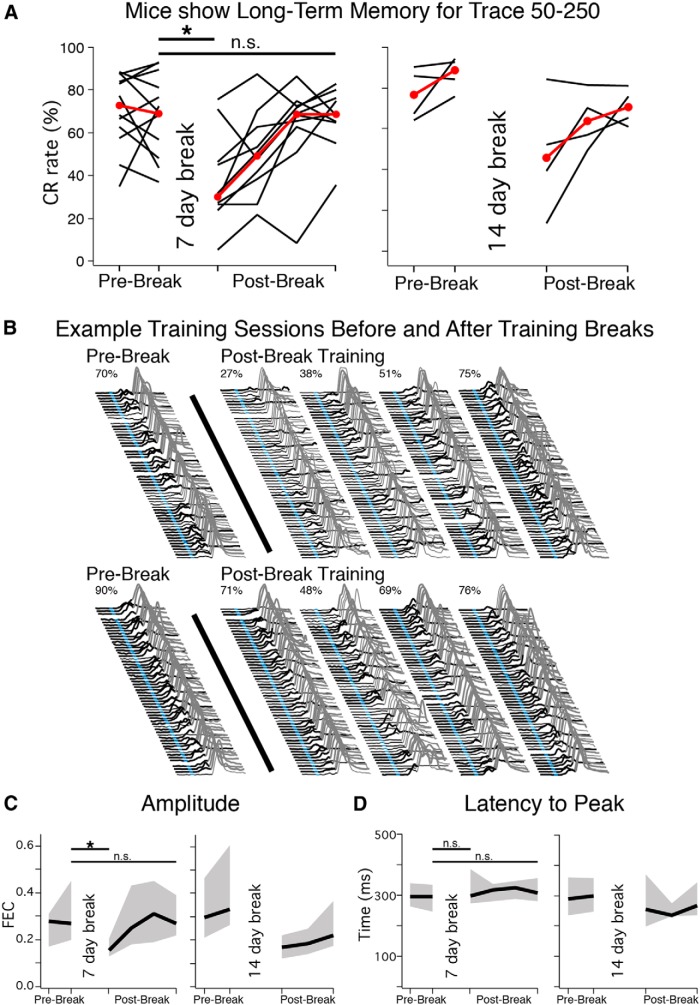
Trained mice receiving a 7 (n = 10) or 14 d (n = 4) break in training showed long-term memory for the task. A, Asymptotic (Prebreak) CR rates and postbreak performance for mice that received a 7 (left) or 14 d (right) break in training (shown separately but analyzed together). Red markers indicate median observed each day. Mice showed a significant decrease in performance during the first postbreak sessions (paired t = 5.69, df = 13, p < 0.001), which recovered with additional training sessions (t = 1.02, p = 0.33). B, Example sessions from two mice before (Prebreak) and after (Postbreak) training breaks. Note that mice showed CRs early in the first postbreak session, even when overall performance was low (top), suggesting that mice remembered rather than quickly relearned the task. C, Similar to CR rate, CR amplitude decreased between prebreak and postbreak sessions (t = 3.99, p = 0.001), which recovered with additional training (t = 0.25, p = 0.81). D, In contrast, the appropriate timing for the task (latency to CR peak) was conserved between prebreak and postbreak sessions (t = 0.69, p = 0.51).